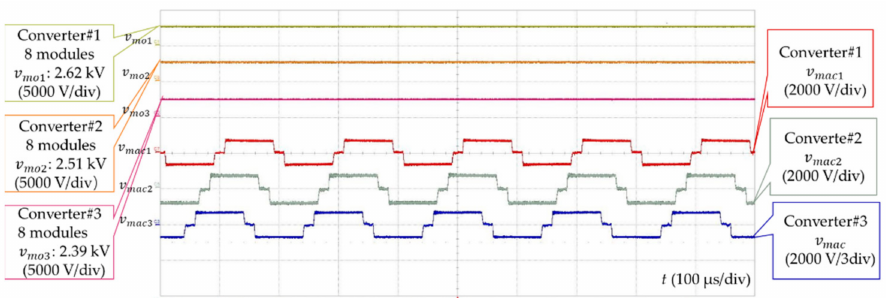
Figure 26. Modules waveform of three converters under the stable irradiance.